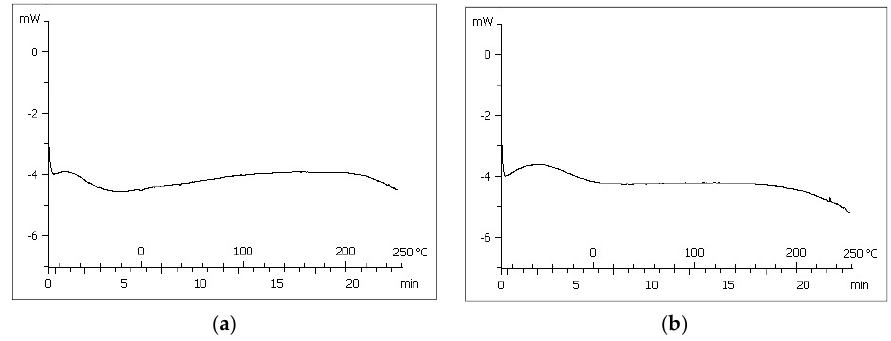
Figure 1. Second cycle DSC thermogram of ( a ) PAMgA 5 and ( b ) PAMgA 40.